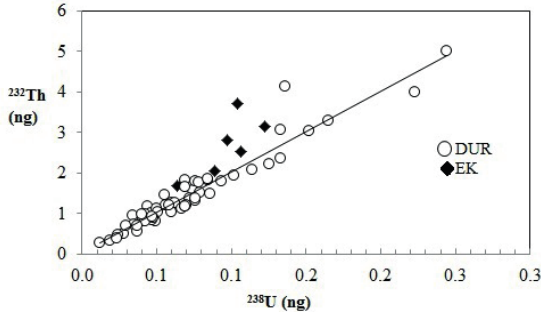
Figure 4 - Concentrations of 238 U and 232 th in 62 fragments of the Durango fluorapatite. Black diamonds represent SUERC (EK) Durango, white circles are UNESP rio Claro DUr UNESP (rC)